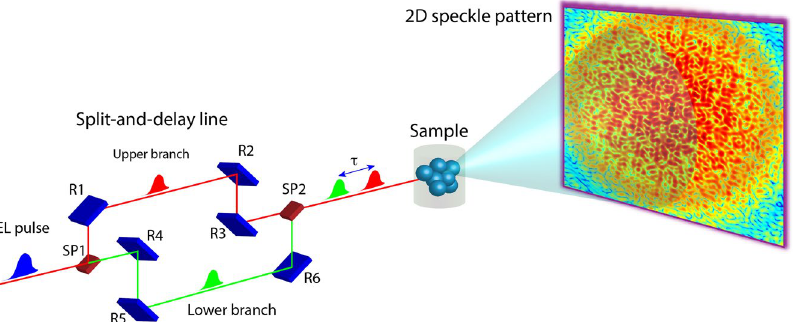
Figure 1. Illustration of the split-and-delay concept with the X-ray Photon Correlation Spectroscopy technique. A single LCLS X-ray pulse is split into two equal intensity pulses using the hard X-ray split-and- delay unit. The pulse paths are recombined and propagate collinearly in the sample direction. The summed speckle pattern from the two pulses is collected by a 2D detector. Contrast of the speckle pattern is analysed as a function of delay time τ